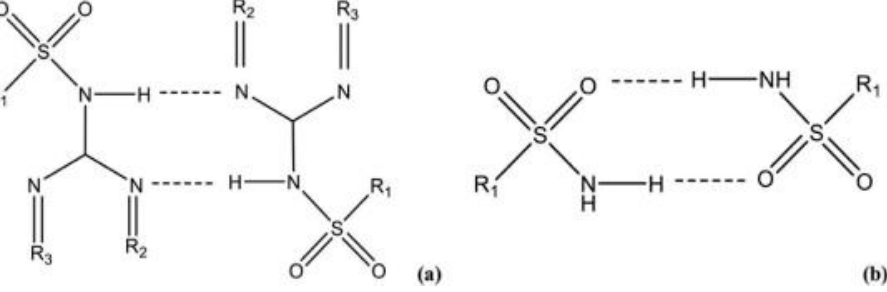
Figure7. Pyrazine-substitutedbenzenesulfonamidesR 2 2 (8)synthons: ( a )basedonN − H sulfonamide ··· N imine Figure 7. Pyrazine-substituted benzenesulfonamides R 22 (8) synthons: ( a ) based on hydrogen bonds (Type I); ( b ) based on N − H amide ··· O sulfone hydrogen bonds (Type II) N − H sulfonamide ···N imine hydrogen bonds (Type I); ( b ) based on N − H amide ···O sulfone hydrogen bonds (Type II) [58].